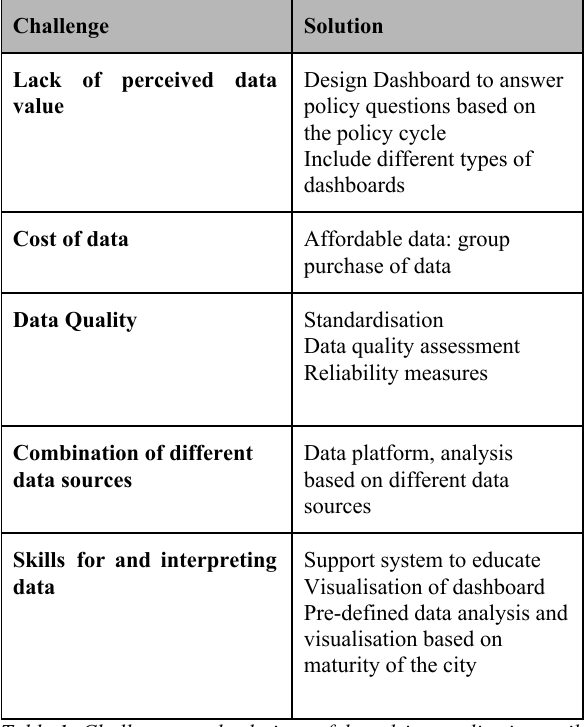
Table 1: Challenges and solutions of data driven policy in retail Lack of perceived data